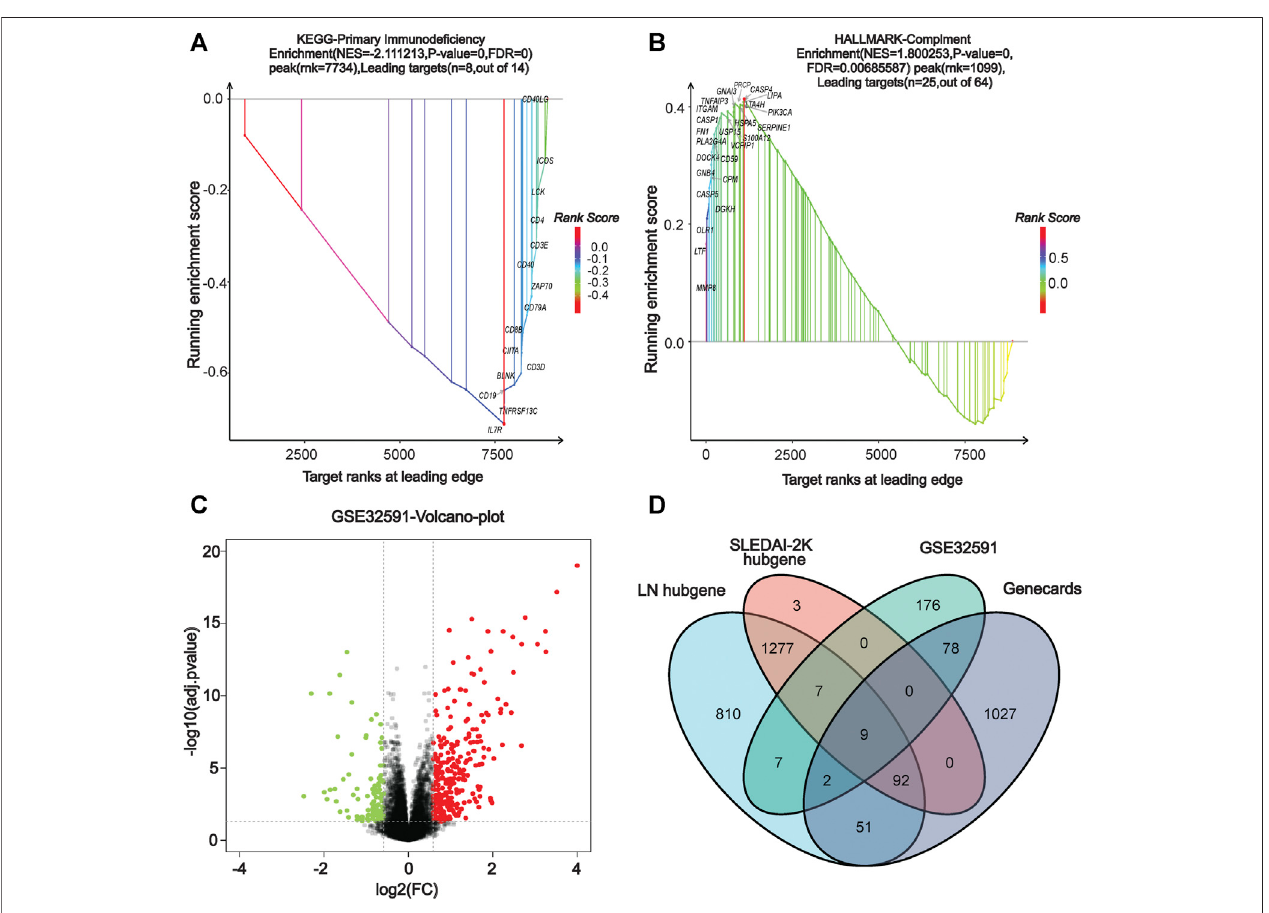
FIGURE 3 | | GSEA enrichment analysis and identi fi cation of co-DEGs. (A) KEGG dataset enrichment results. (B) HALLMARKER dataset enrichment results. (C) Volcano map of GSE32591 differentially-expressed genes. (D) Venn diagram screening for co-differentially-expressed genes.